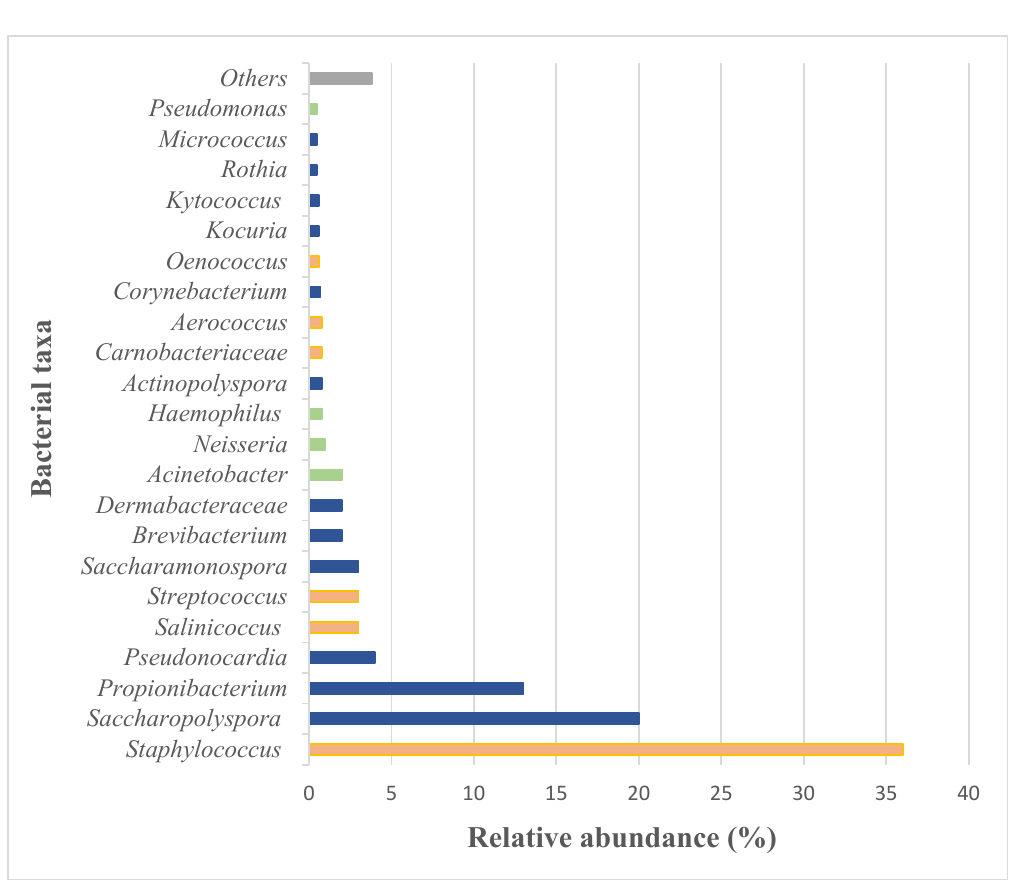
Figure 7. Relative abundance of the bacterial taxa (genera or family) showing ≥ 0.5% of total bacterial reads in the microbiome of the Glagolita Clozianus . Actinobacteria : blue (47% of bacteria); Firmicutes : orange (46% of bacteria); Proteobacteria : green (5% of bacteria). Others: grey (bacteria showing a relative proportion under 0.5% cut ‐ off).